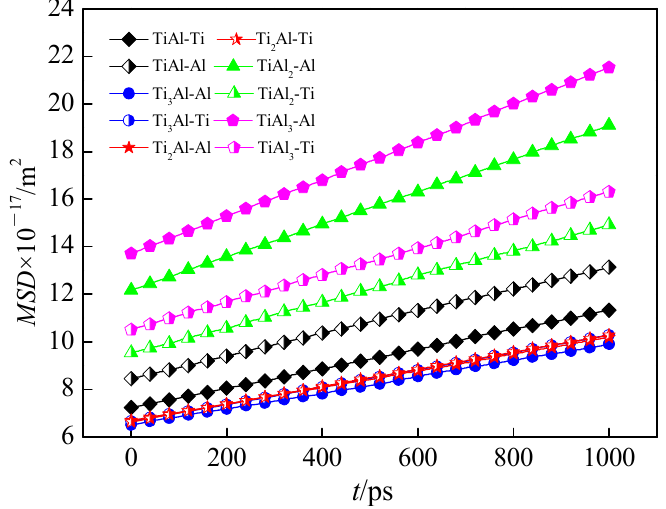
Figure 7. MSD of Ti and Al atoms at 2500 K for Ti-Al alloys with different atomic ratios.